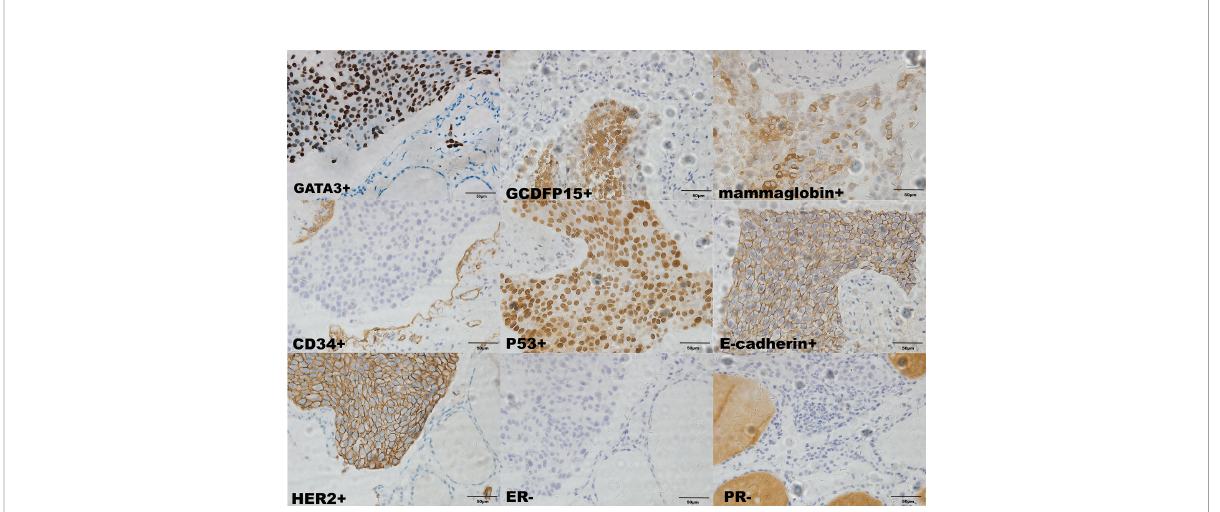
FIGURE 4 Immunohistochemical staining of the biopsy specimen from the thyroid (×400). Ki-67+ (60%); GCDFP15+; mammaglobin+; CD34+; P53+; E- cadherin+; HER2+; ER-;